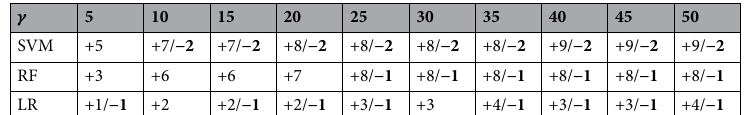
c + c − . The numbers in the